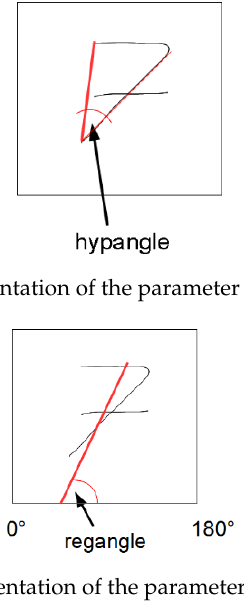
Figure 6. Representation of the parameter “HYP_ANGLE” .